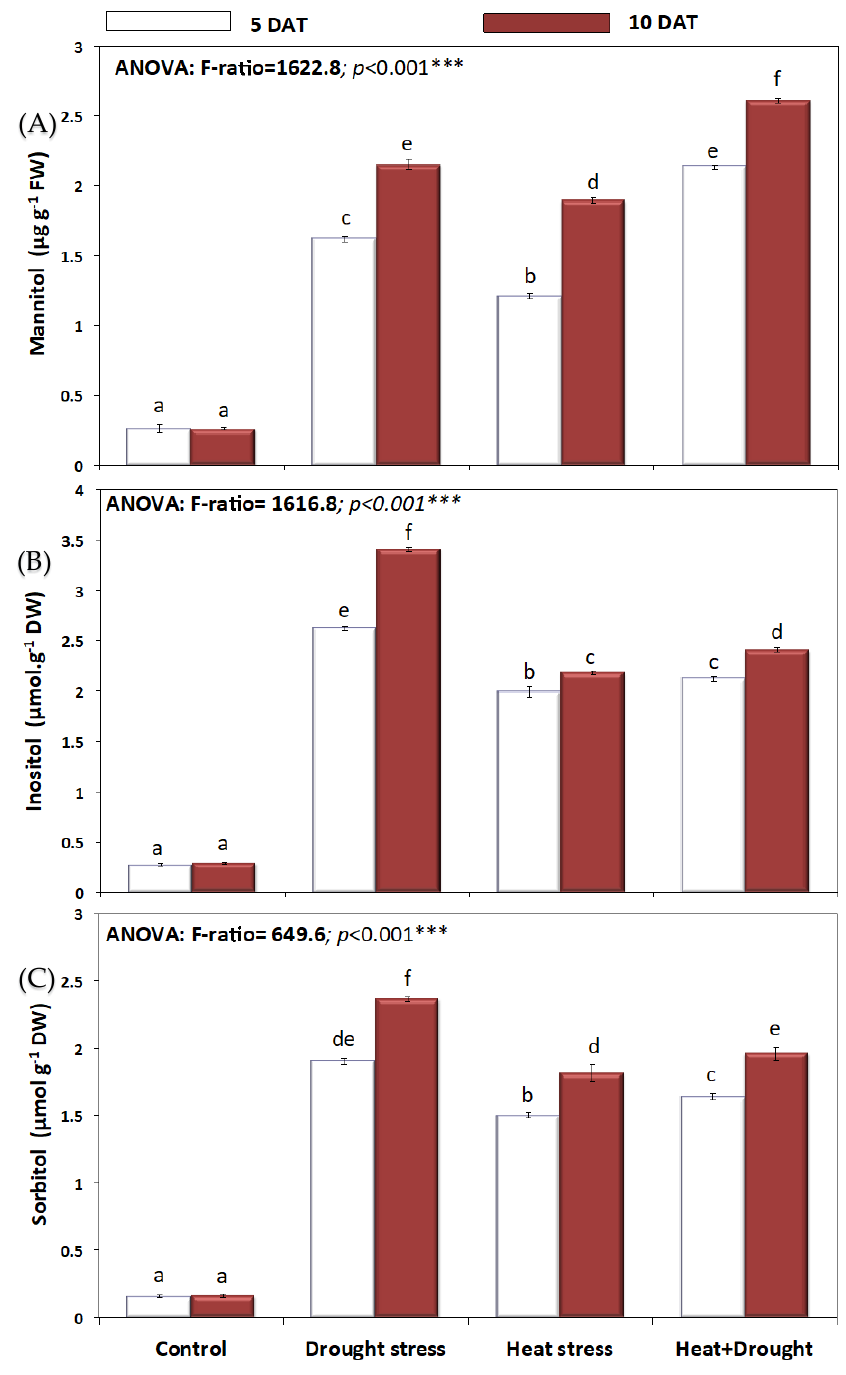
Figure 10. Effect of drought, heat, and interaction between drought and heat stresses on ( A ) mannitol ( µ g g − 1 FW), ( B ) inositol ( µ mol. g − 1 FW), and ( C ) sorbitol ( µ mol. g − 1 FW) of A. sieberi alba. Data expressed as mean of triplicates, error bars represent standard error for means. Means marked with different letters are significantly different according to ANOVA and DMRTs at p < 0.05.